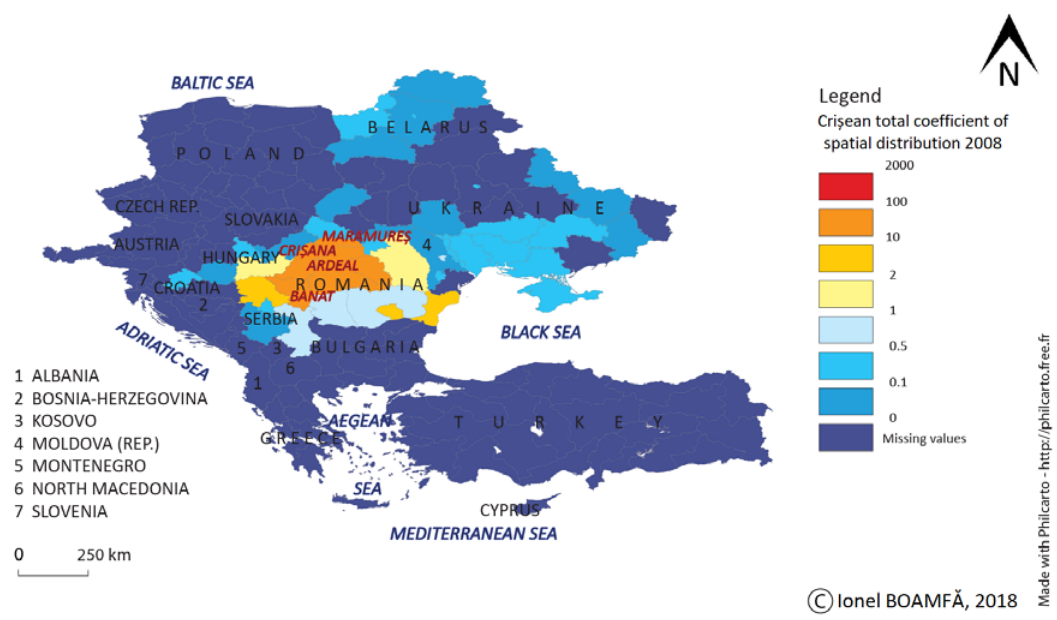
Figure 13 . G eographical repartition of the anthroponym Crișean. Coef. of spatial distribution